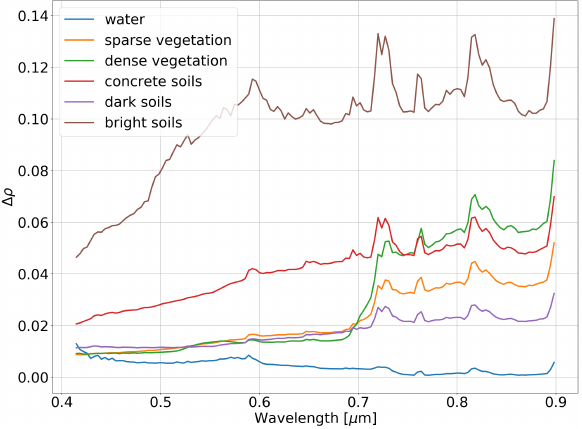
Figure 5. Surface reflectance error of the estimated reflectance. The figure 5 shows the approach to estimate ρ corrected